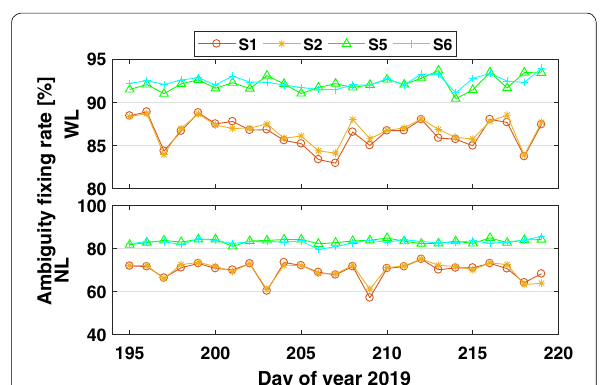
Fig. 15 BDS-3 ambiguity fixing